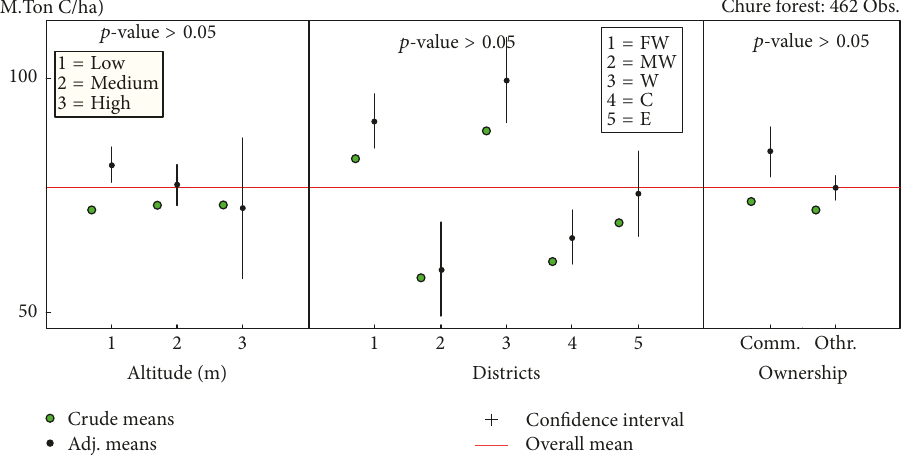
(M.Ton C/ha) Chure forest: 462 Obs.